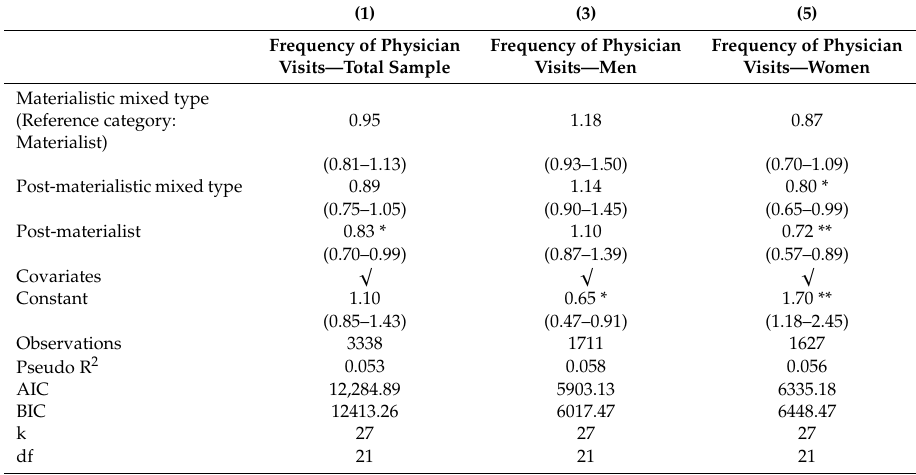
Table 2. Determinants of frequency of physician visits (total sample and stratified by sex). Results of negative binomial